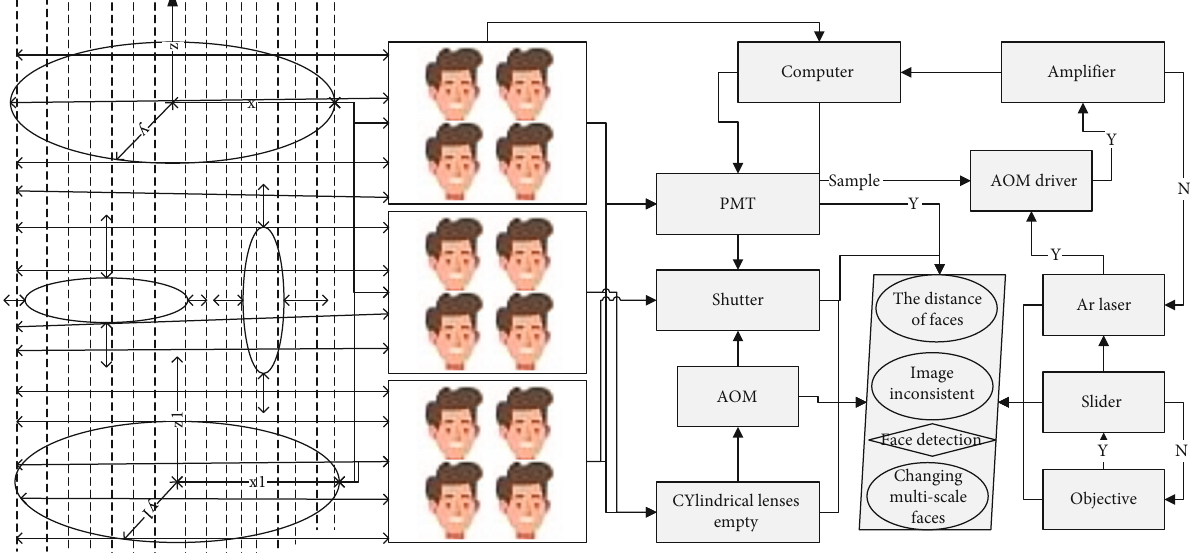
Figure 1: Three-dimensional anisotropic di ff usion video recognition